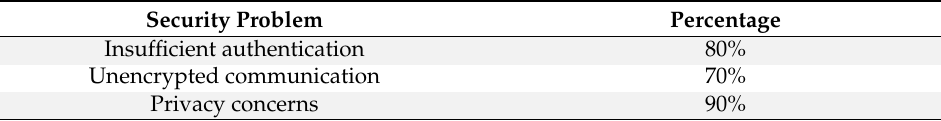
Table 2. Security problems faced by the IoMT and IoT